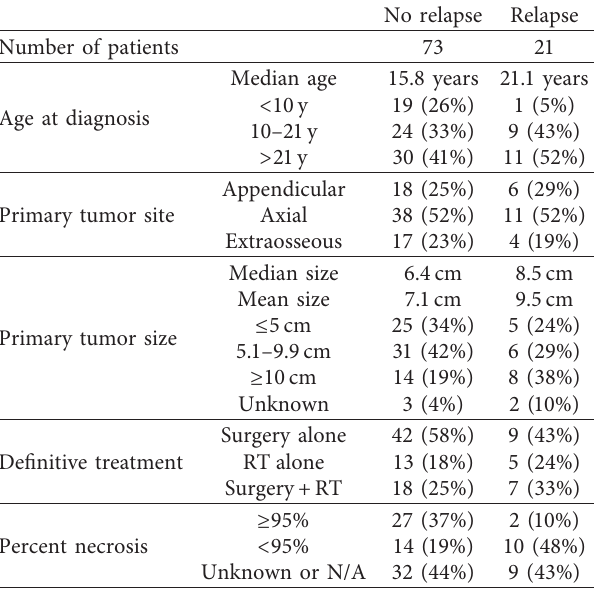
Figure 1: Flowchart of identification of patients with localized Ewing sarcoma (ES) treated at Johns Hopkins Hospital (JHH). EMR: electronic medical record. Table 1: Patient, tumor, and treatment characteristics of localized Ewing sarcoma